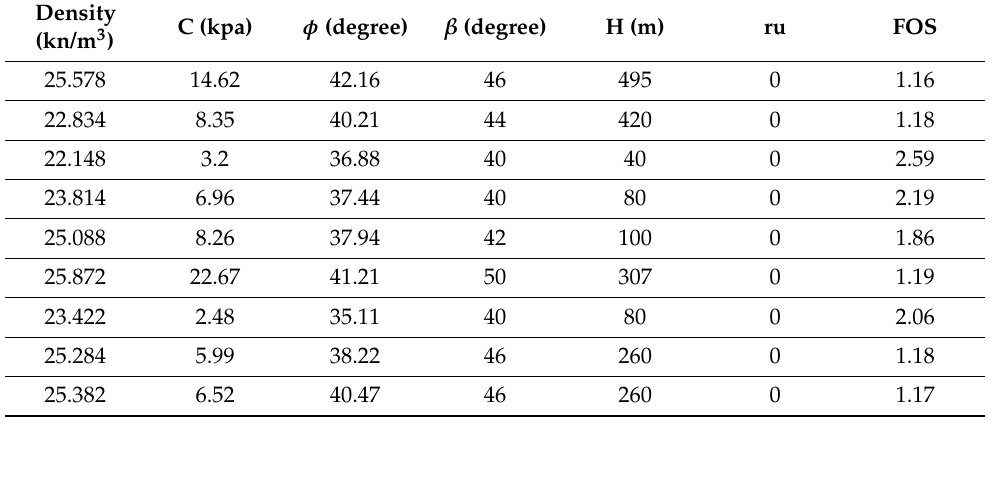
Table 6. Additional data for the purpose of model verification.